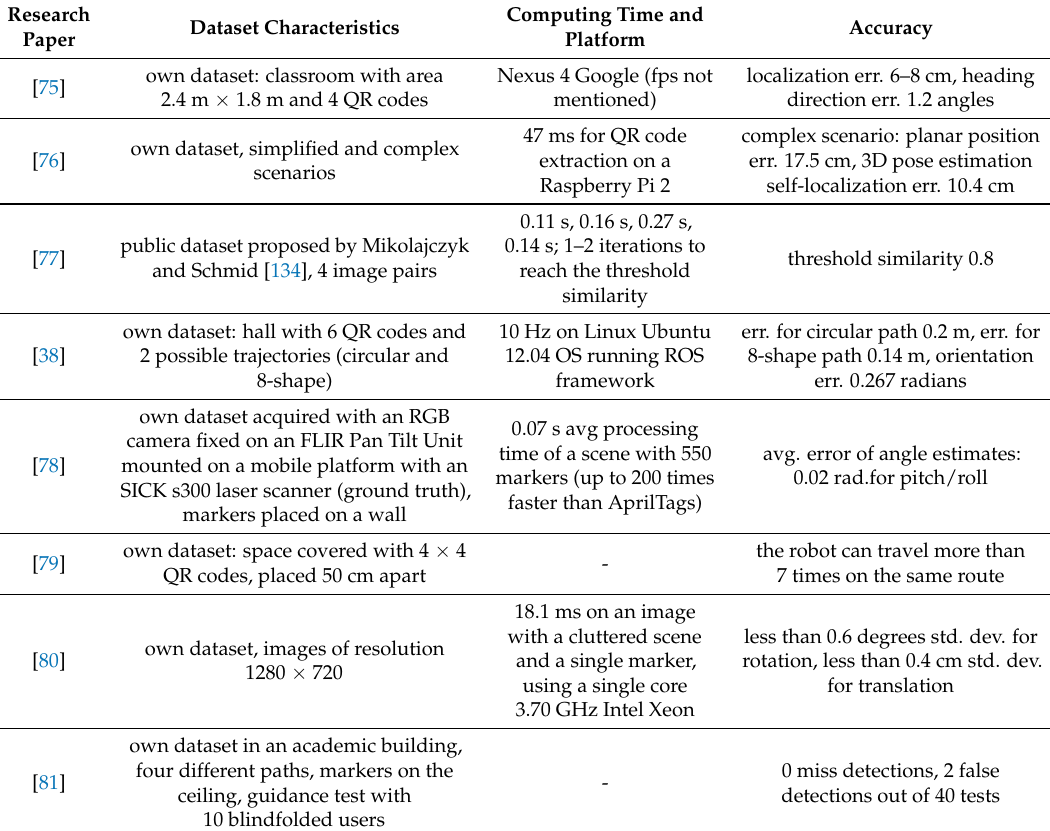
Table 5. Characteristics of indoor localization solutions with 2D mobile cameras, markers with known positions, and traditional image